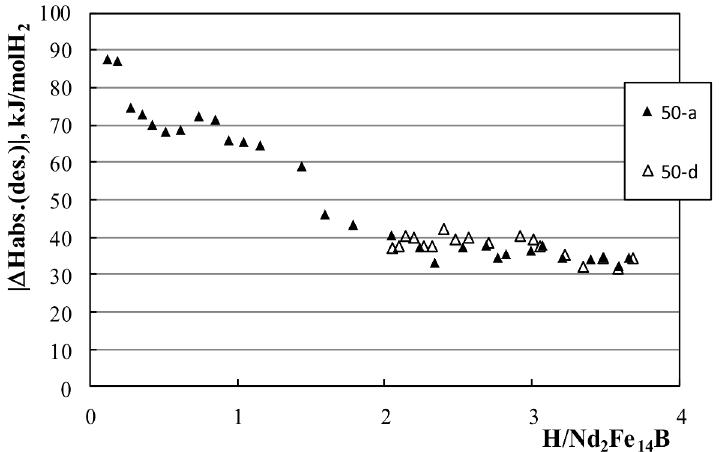
Figure 4. Absorption and desorption of enthalpy vs. composition at 50 ◦ C for the Nd 2 Fe 14 B-H 2 system. The different symbols refer to different runs of determination. Filled symbols refer to absorption of H, while the open symbols refer to the